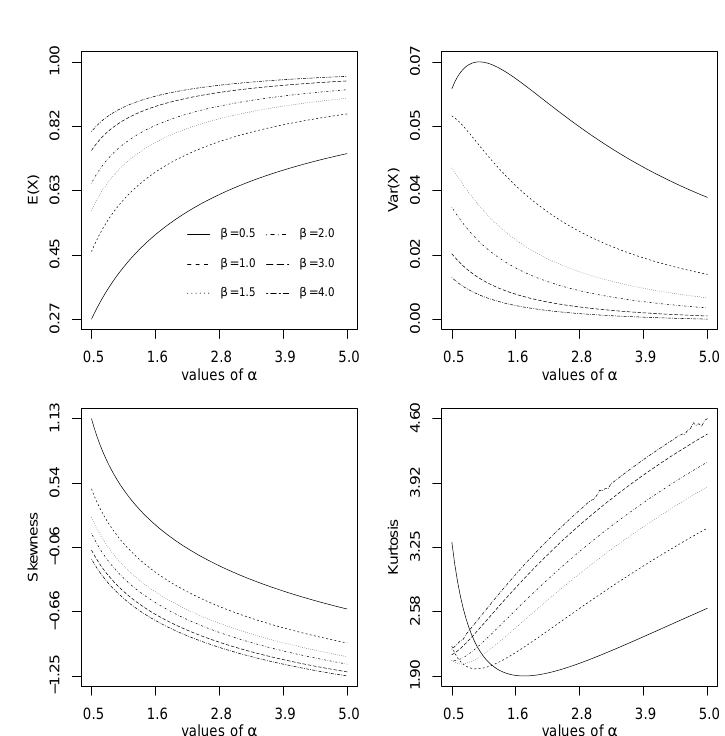
Figure 3 – Mean, variance, skewness and kurtosis of the unit-Gompertz distribution considering different values of α and β